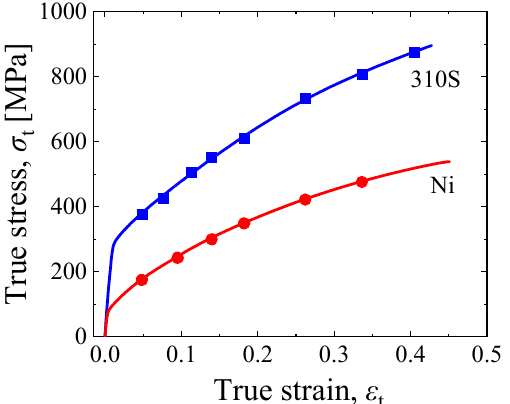
Figure 4. Inverse pole figure (IPF) maps before tensile deformation of the specimens: ( a ) 310S and ( b ) Ni.